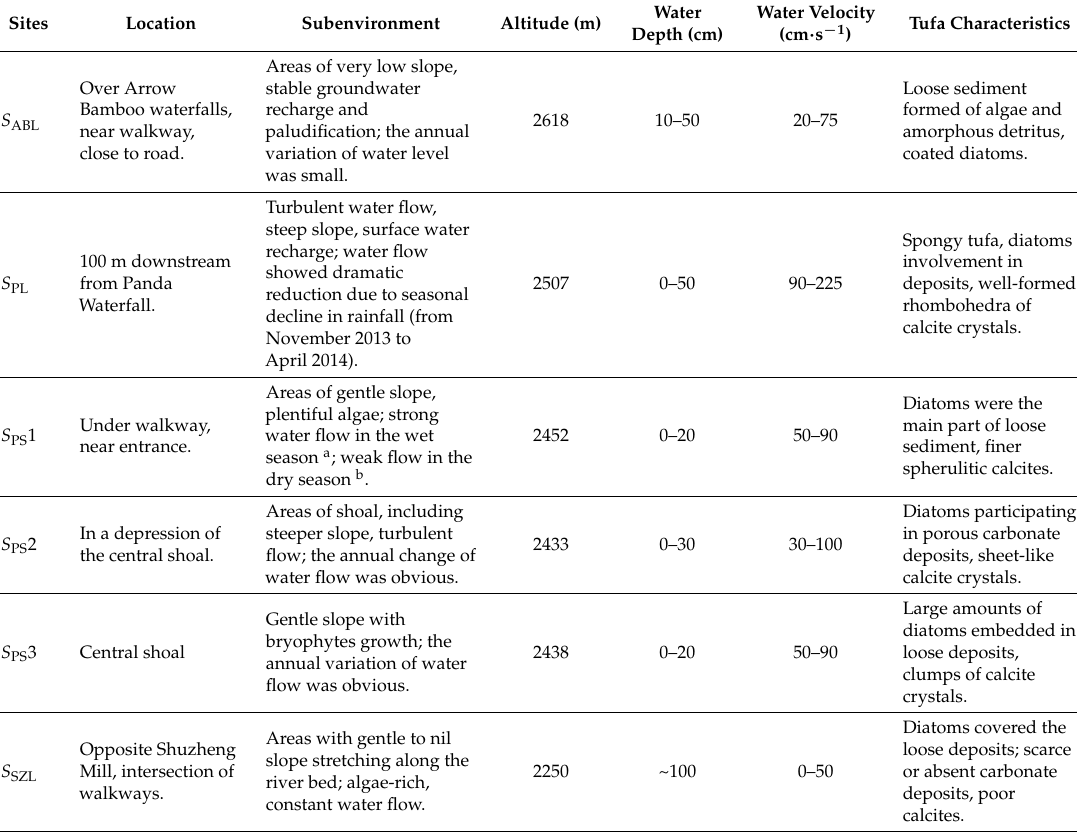
Table 1. Main characteristics of the tufa depositional